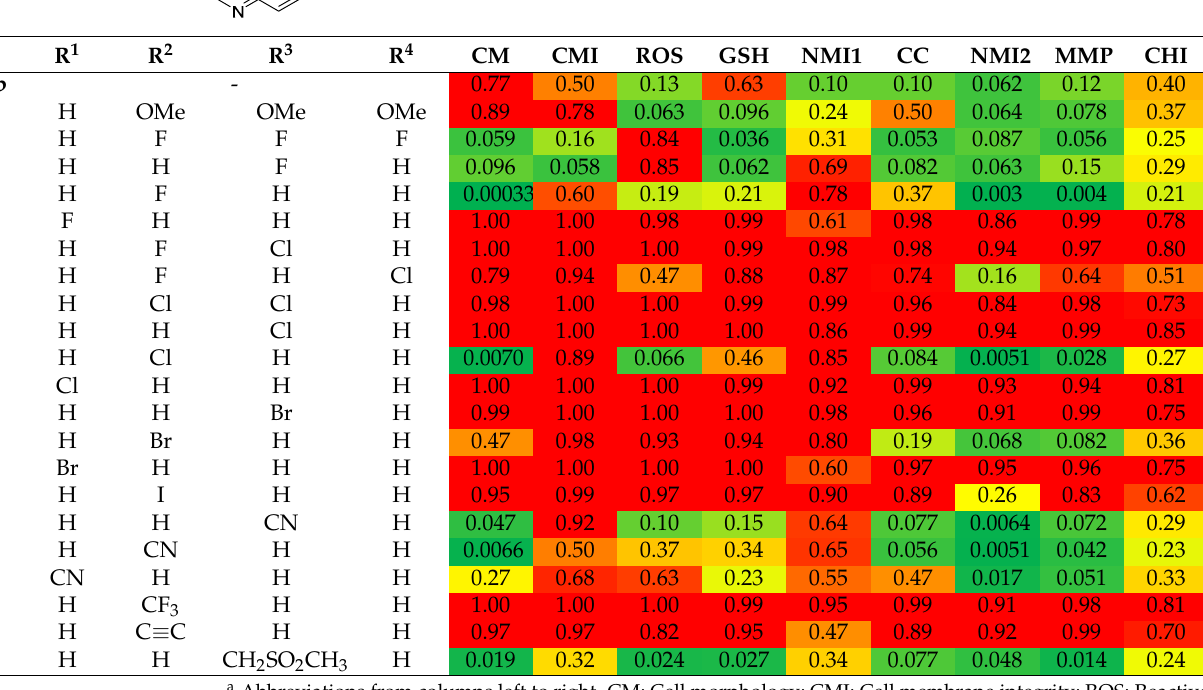
The N -(3,4-dichlorophenyl)-6-(trifluoromethyl)quinolin-4-amine ( 87 ) analog